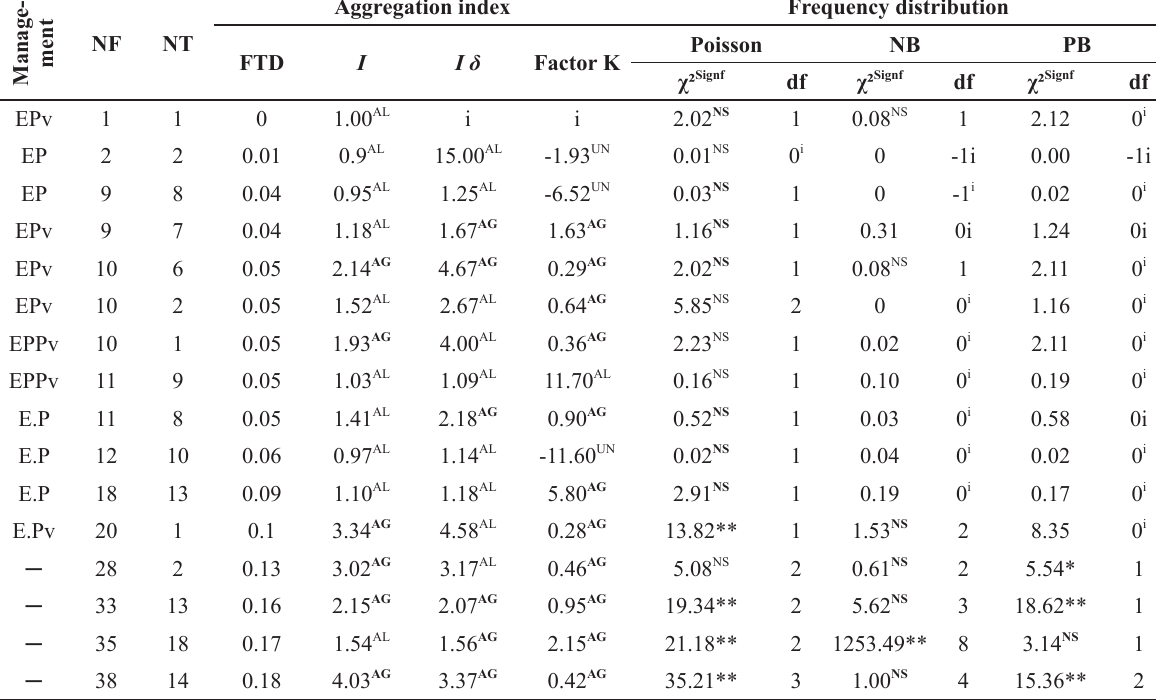
Infestation by Anastrepha spp. caught in McPhail traps, aggregation indices, test of fit of the data to the distribution in the three orchards during 23 weeks in the region of Ivinhema, State of Mato Grosso do Sul, Brazil from August 2013